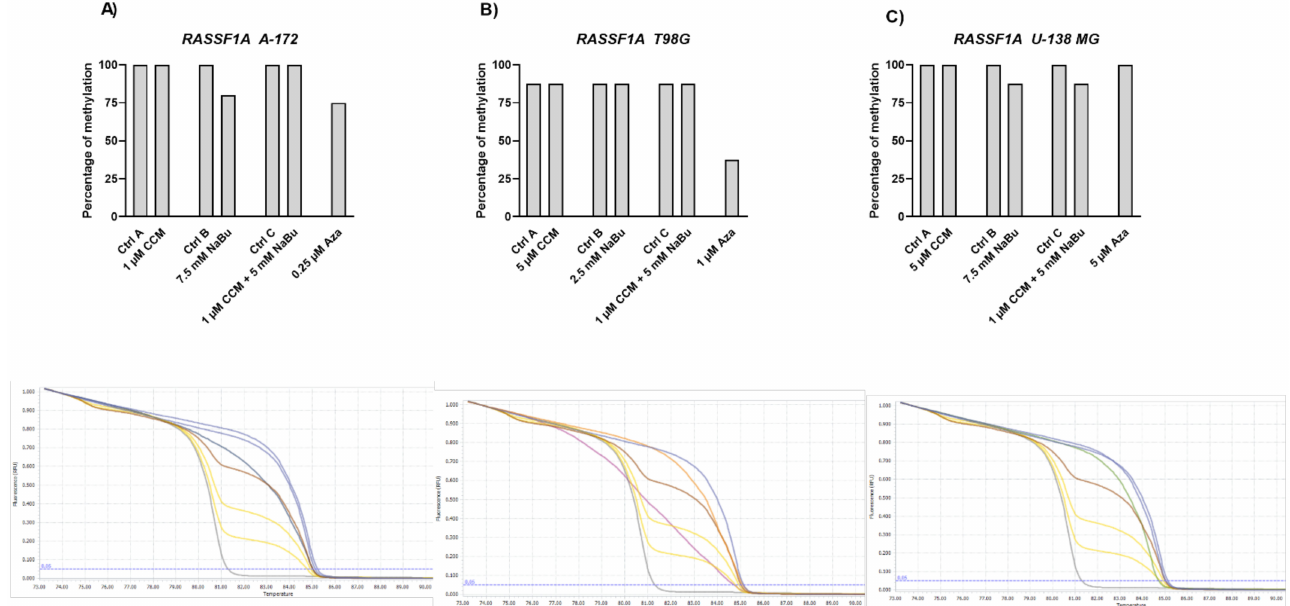
Figure 11. Results of MS-HRM analysis with representative melting curves of RASSF1A promoter methylation in A-172 ( A ), T98G ( B ), and U-138 MG ( C ) cell lines. Cells treated with vehicle (DMSO, PBS or both) are designated as Ctrl A, Ctrl B, and Ctrl C, respectively. Due to semiquantitative nature of generated results, no SEM bars are shown. Below each bar chart melting curves of control and best demethylating compound/combination are presented, together with subsequent controls: 100%, 75%, 50%, 25%, and 0% methylated controls (blue, brown, upper yellow, lower yellow, grey, respectively). For A-172 cell line, melting curve generated after treatment with 5-Aza is presented (dark blue, close to brown, 50% methylated control) regarding Ctrl A (blue line, close to 100% methylated control). For T98G cell line, also Aza is presented (pink) regarding Ctrl A (orange). In case of U-138 MG cell line, 7.5 mM NaBu is presented (green) in relation to Ctrl B (blue line, close to 100% methylated